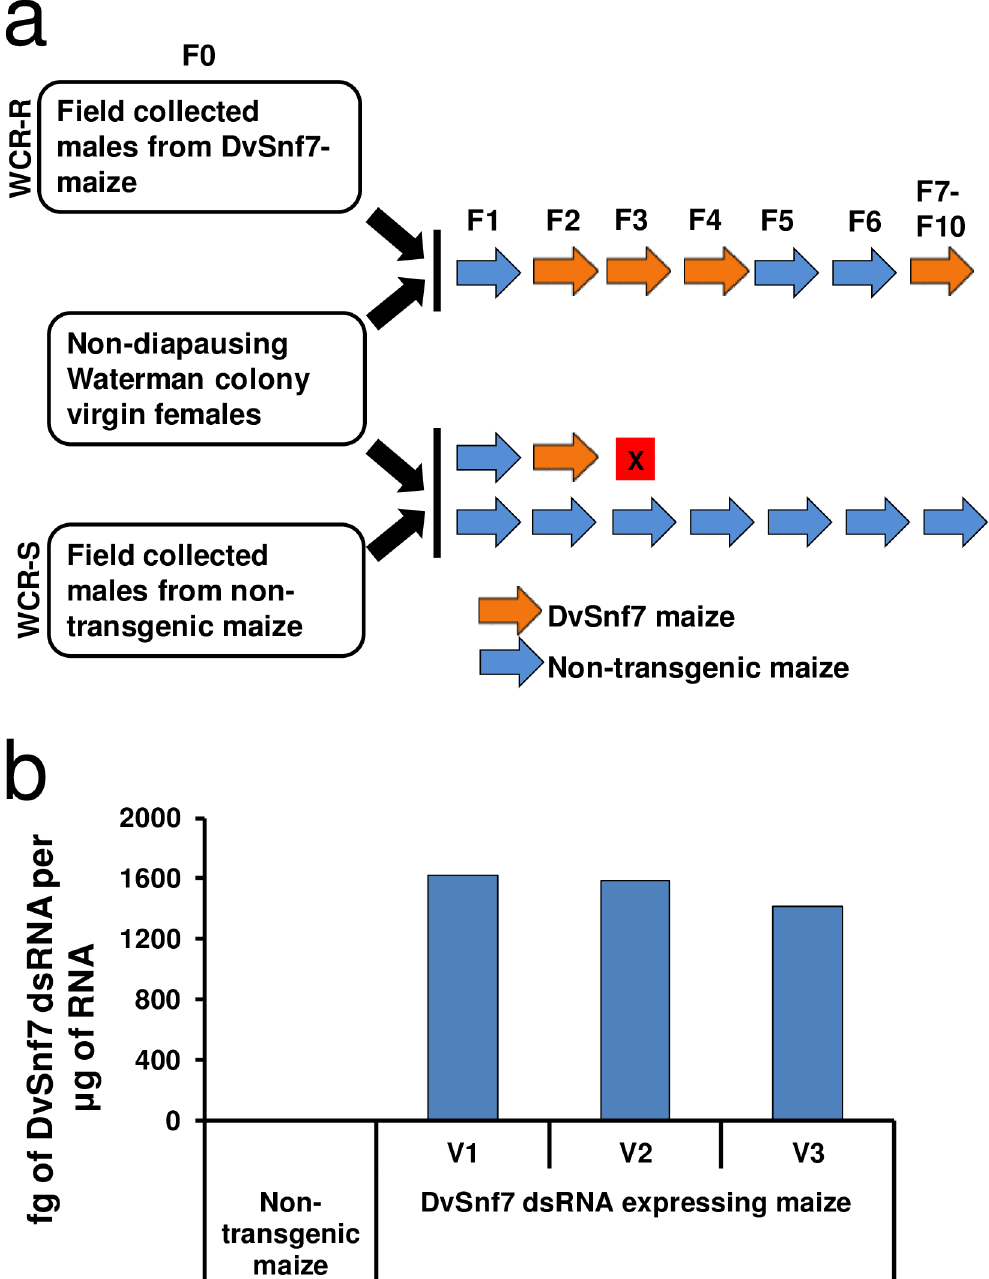
Fig 1. Establishing a WCR colony resistant to DvSnf7 dsRNA. ( a ) Selection regime used to establish DvSnf7 dsRNA resistant (WCR-R) and susceptible (WCR-S) colonies. A total of 350 beetles were collected from field-tented plots containing maize plants expressing DvSnf7 dsRNA for WCR-R, and 500 beetles from the surrounding area containing non- transgenic maize for WCR-S. Field collected males were allowed to mate with virgin females from the non-diapausing Waterman lab colony to produce non-diapausing colonies. From F1 onwards, beetles were sib-mated and reared on either DvSnf7 or non-transgenic maize roots. From F11, the WCR-R colony was selected on DvSnf7 maize every other generation. ( b ) Expression of DvSnf7 dsRNA in DvSnf7 maize roots (ZM_S295399) at three vegetative stages (V1, V2 and V3). Non- transgenic maize roots were used as a control. Bar graph, median. DvSnf7 dsRNA expression in the DvSnf7 dsRNA maize was not significantly different ( p = 0.402) within developmental stages. Root samples were collected from maize grown in root mats used for rearing all generations of both colonies in growth chambers.